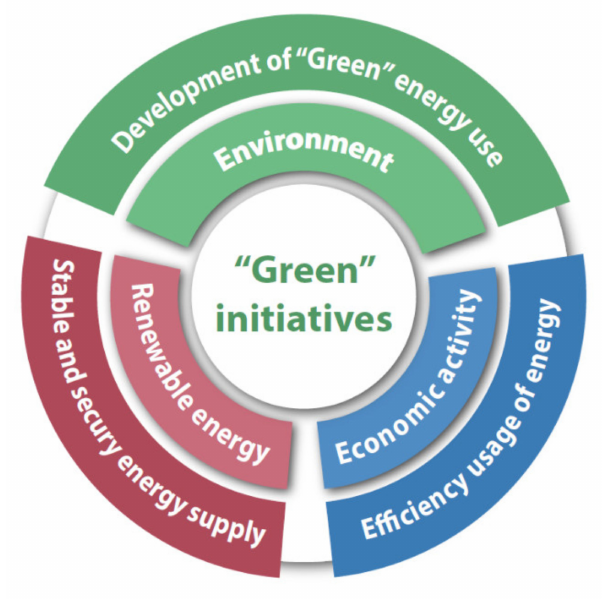
Figure 1. Framework of “Green” initiatives.